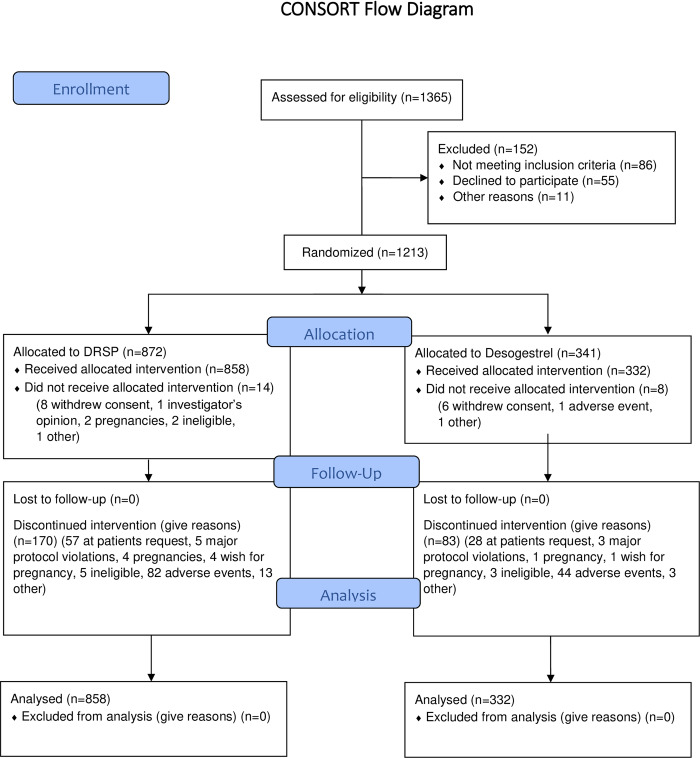
Consort of the study.